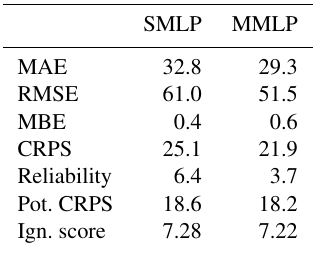
Table 8. Comparison of the overall performance evaluation using deterministic performance evaluation metrics of the two MLP mod- els and the regression models, evaluated using the testing data